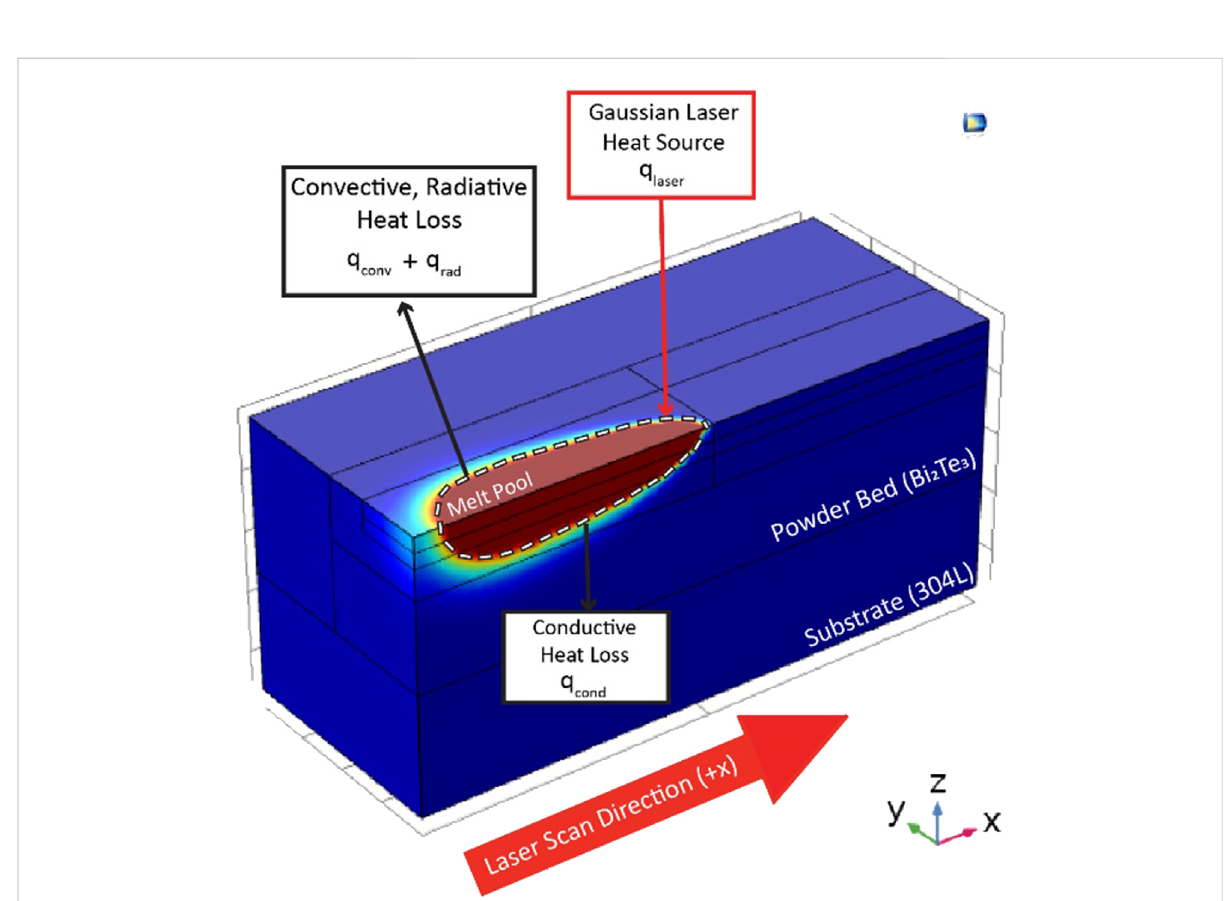
FIGURE 3 Schematic showing boundary conditions applied in the numerical model. The laser heat input and heat dissipation occurred at the top of the Bi 2 Te 3 powder bed whereas the bottom of the powder bed has an adiabatic boundary condition ( q ″ (cid:1) 0 ). The initial condition assumes thermal equilibrium with the ambient temperature ( T 0 = 300